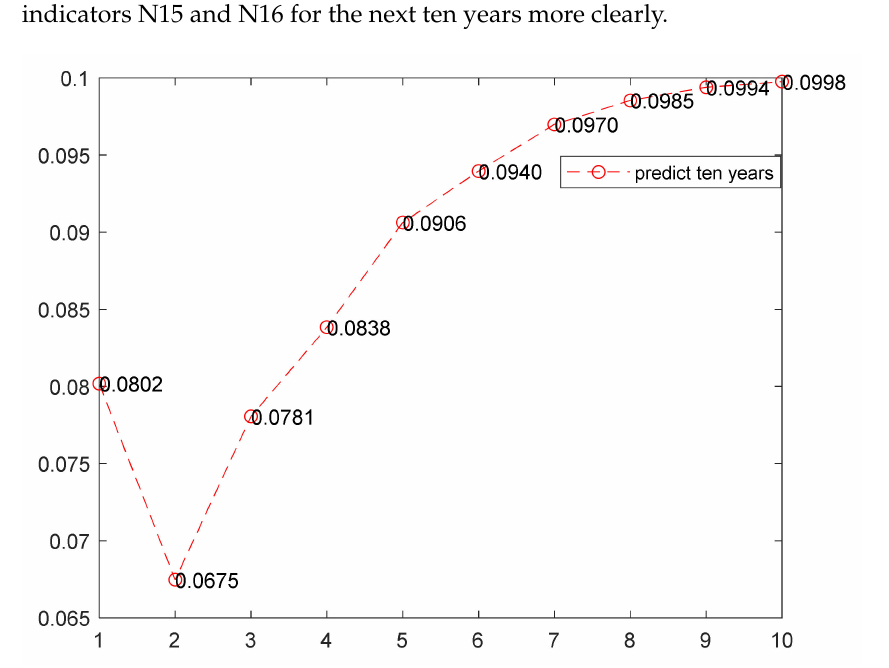
Figure 7. The prediction results of indicator N15 for the next 10 years.